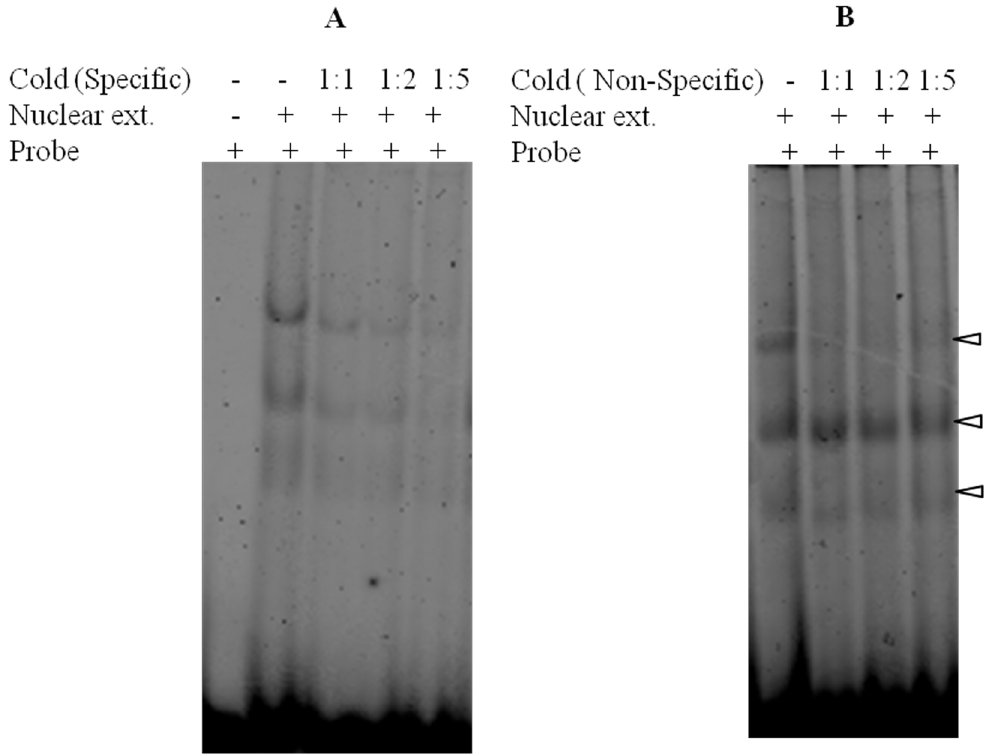
Fig 3. Interaction of INO80 binding motif with nuclear extract from HEK 293T cells. Results of EMSA with Cy3 labeled specific oligo at ratio of 1:5 in all the experiments. The unlabeled competing oligos both specific(A) and non-specific(B) were varied at different molar ratios as indicated at the top of the lanes. The arrow heads indicate the three retarded oligo nucleotides.